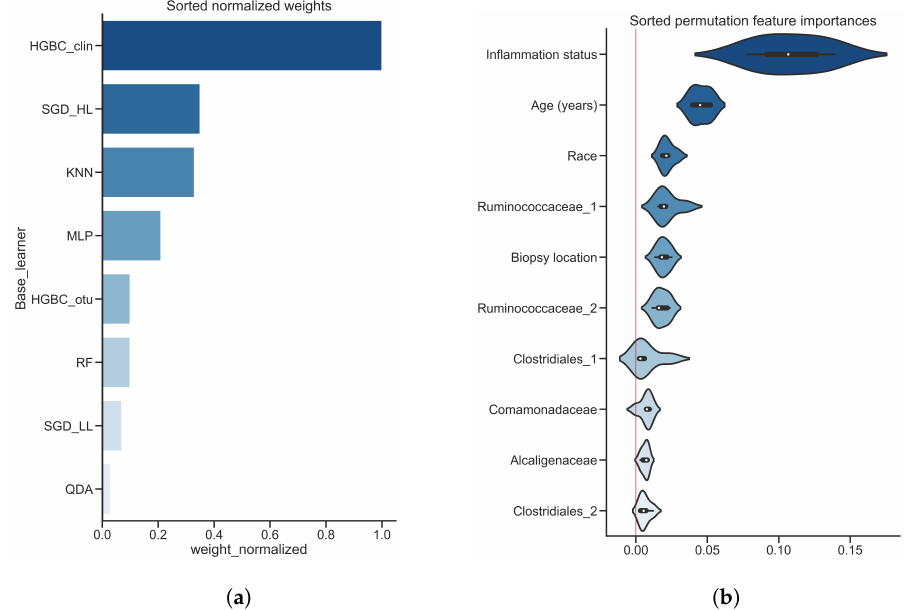
Figure 3. Sorted feature importance values, inflammatory bowel disease dataset, training set. ( a ) Normalized regression weights obtained from a meta learner used in stacked classifier; ( b ) Violin plots of permutation feature importance values obtained from a stacked classifier. Red vertical line represents zero importance